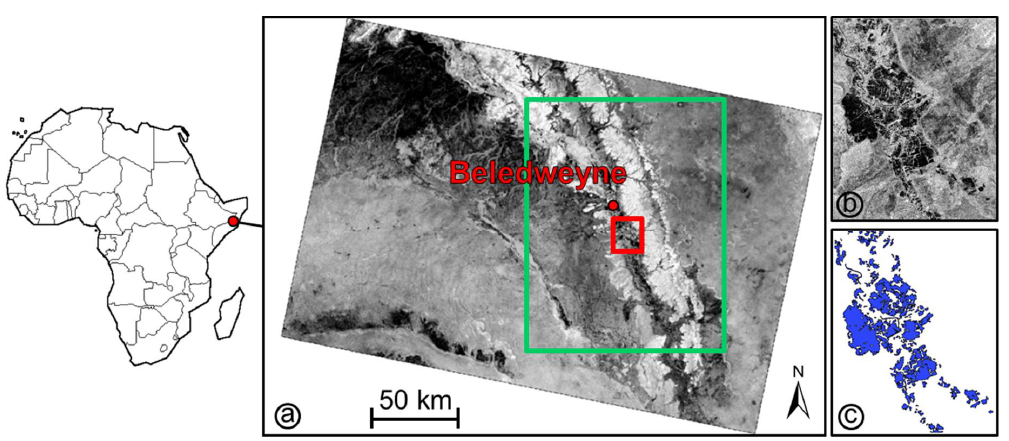
Figure 1. ( a ) Sentinel-1 VV polarized data set covering parts of Somalia and Ethiopia during flooding at Shabelle River on 30 May 2016. The green rectangle visualizes the study area in Somalia (6.090 ◦ N, 44.535 ◦ E (upper left); 4.090 ◦ N, 45.817 ◦ E (lower right)); the red rectangle represents the validation area